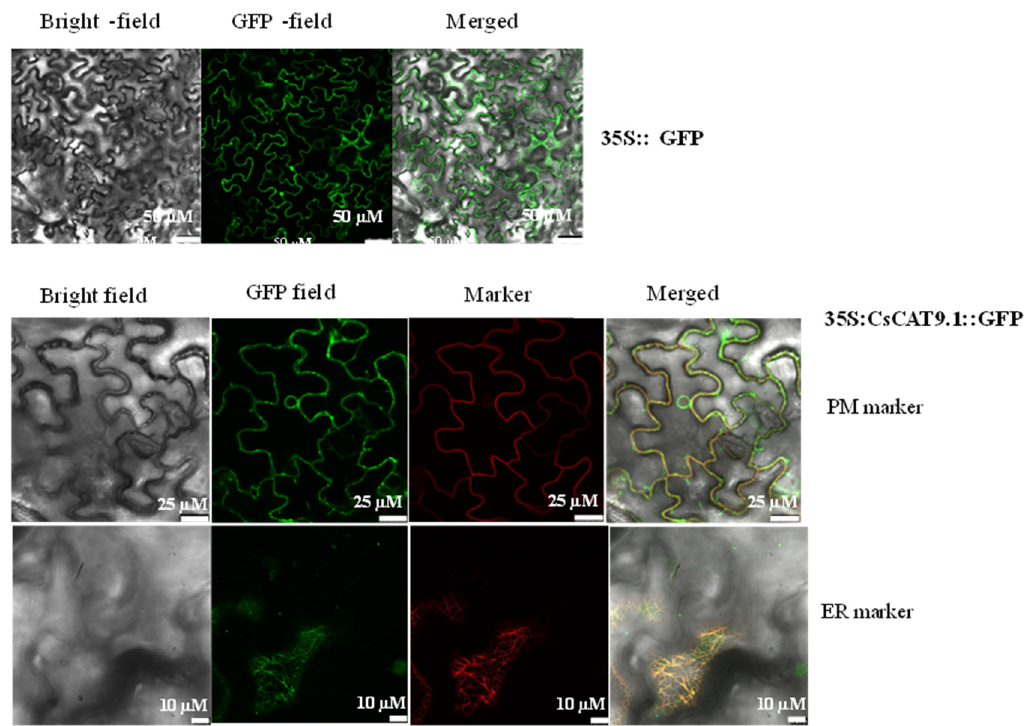
Figure 5. Subcellular localization of transiently expressed fusion proteins for 35S::CsCAT9.1::GFP with plasma membrane marker (PM) and endoplasmic reticulum (ER) marker in Nicotiana benthamiana leaves. Scale bars = 50 μ M (35S::GFP as control) and 25 μ M (35S::CsCAT9.1::GFP) using PM marker, 10 μ M (35S::CsCAT9.1::GFP) for ER marker.